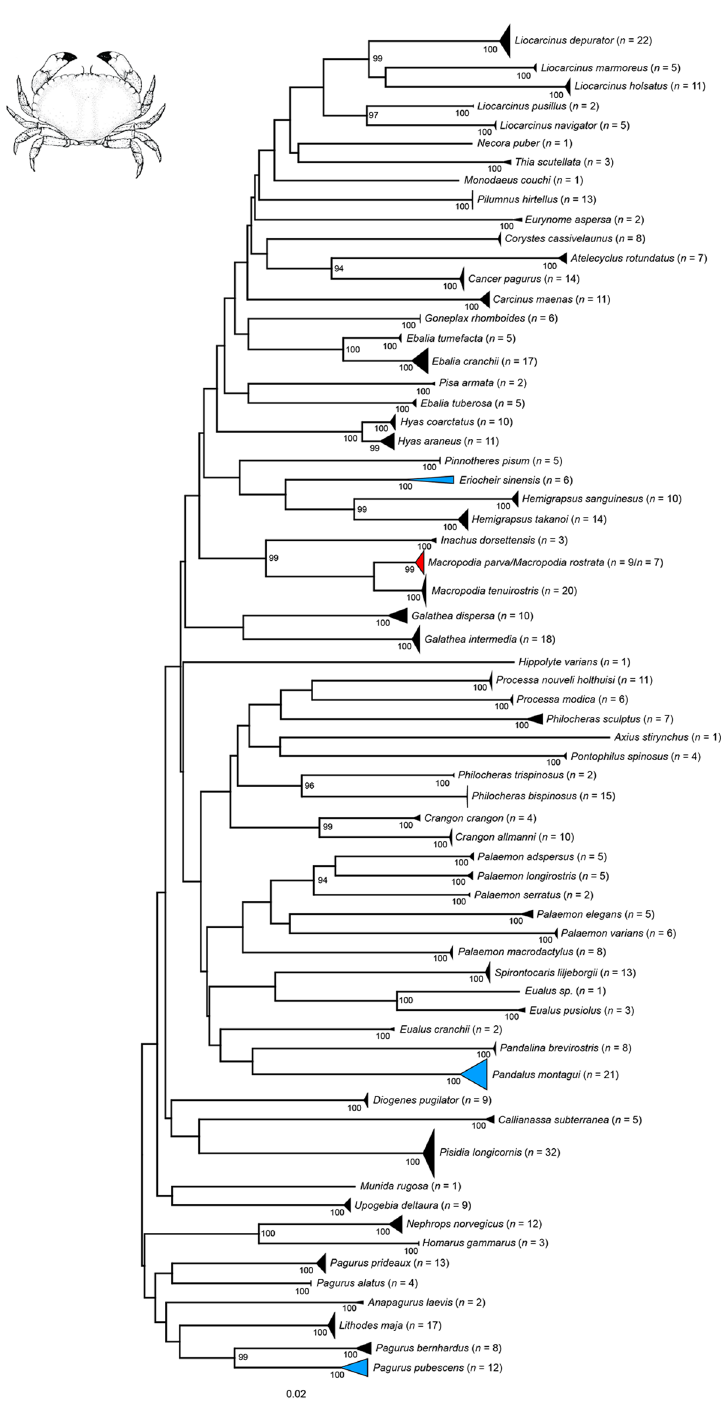
Fig 3. Neighbor joining topology of the analyzed Decapoda based on Kimura 2-parameter distances. The number of analyzed specimens collapsed into a single node is provided following the species name. Triangles indicate the relative number of individual ’ s sampled (height) and sequence divergence (width). Blue triangles indicate species with intraspecific maximum pairwise distances > 2.2%), the red triangle species with interspecific distance values < 2.2%. Numbers next to nodes represent non-parametric bootstrap values > 90% (1,000 replicates). Drawing of Cancer pagurus Linnaeus, 1758 is taken and modified from a previous publication